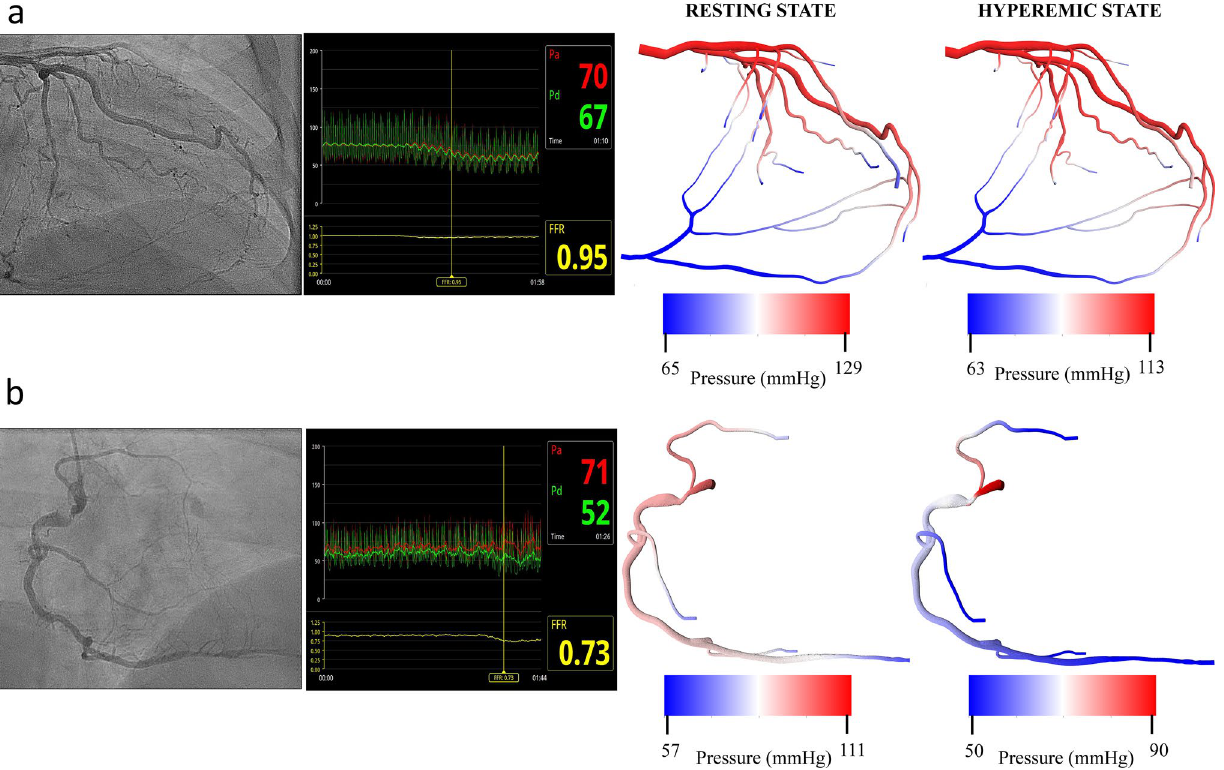
Figure 2. Pressure gradient in arterial geometries at resting and hyperemic conditions. ( a ) Left coronary artery with a non-significant lesion (<50%) and collateral vessels. Pressure gradient at rest and hyperemic states derived from CFD-CA methodology does not change significantly, as shown on the right. ( b ) Right coronary artery with a significant proximal lesion (>70%). Pressure gradient at rest and hyperemic states derived from CFD-CA methodology changes significantly, as noted on the